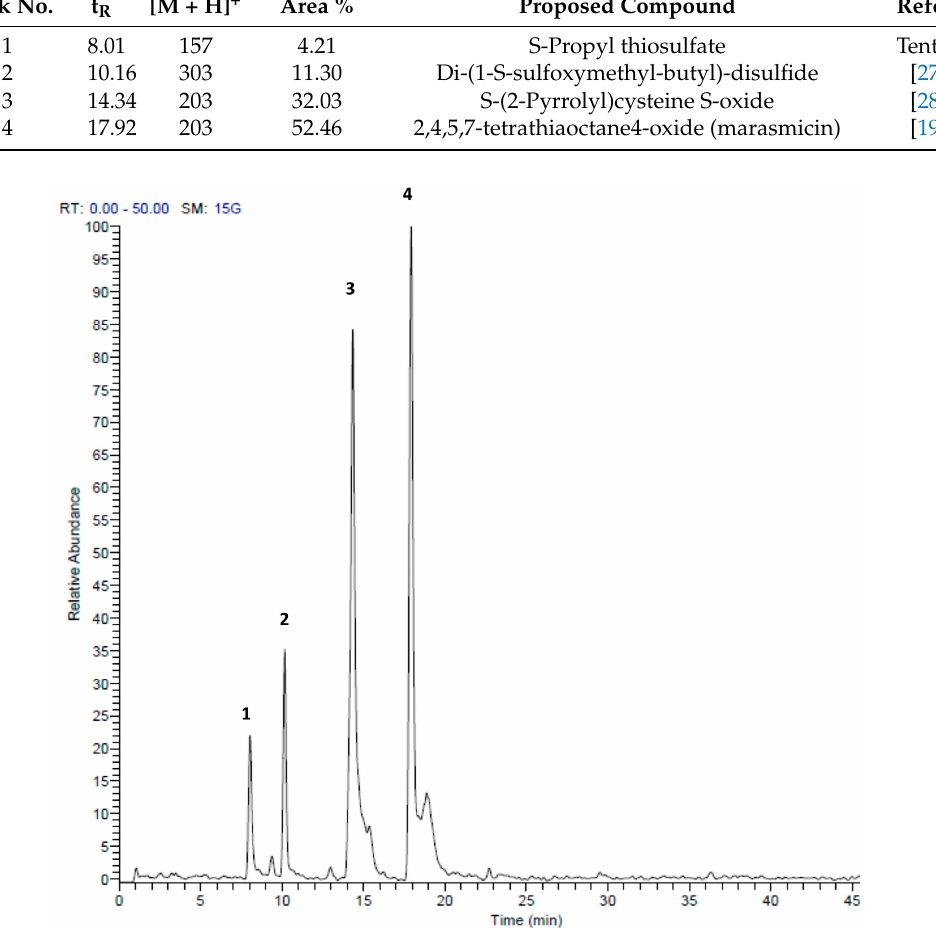
Table 2. Identification of secondary metabolites in the Tulbaghia violacea extract by LC-ESI-MS/MS. Peak No.